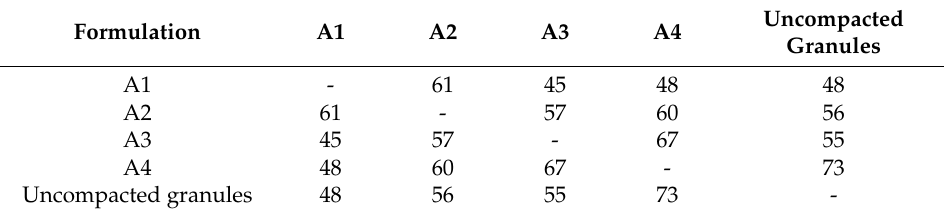
Table 5. Summary of similarity factors ( f 2 ) of the drug release among